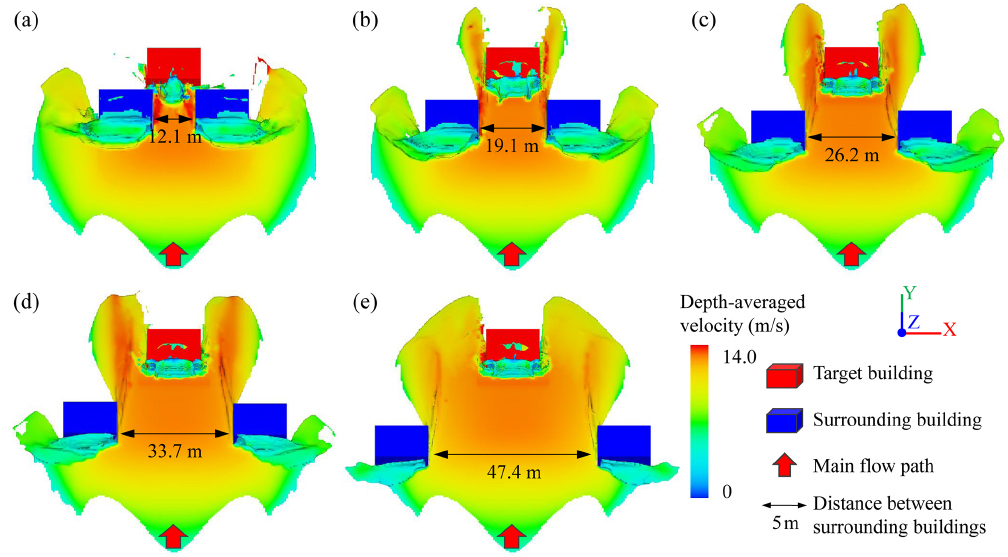
Figure 12. Snapshots for debris flow intensities in the scenarios of Or90-Op0.4- A 45- Dx at a simulation time of 8.0s. Panel (a) is the case of Or90-Op0.4- A 45- D 5, (b) is the case of Or90-Op0.4- A 45- D 10, (c) is the case of Or90-Op0.4- A 45- D 15, (d) is the case of Or90-Op0.4- A 45- D 20 and (e) is the case of Or90-Op0.4- A 45- D 30.